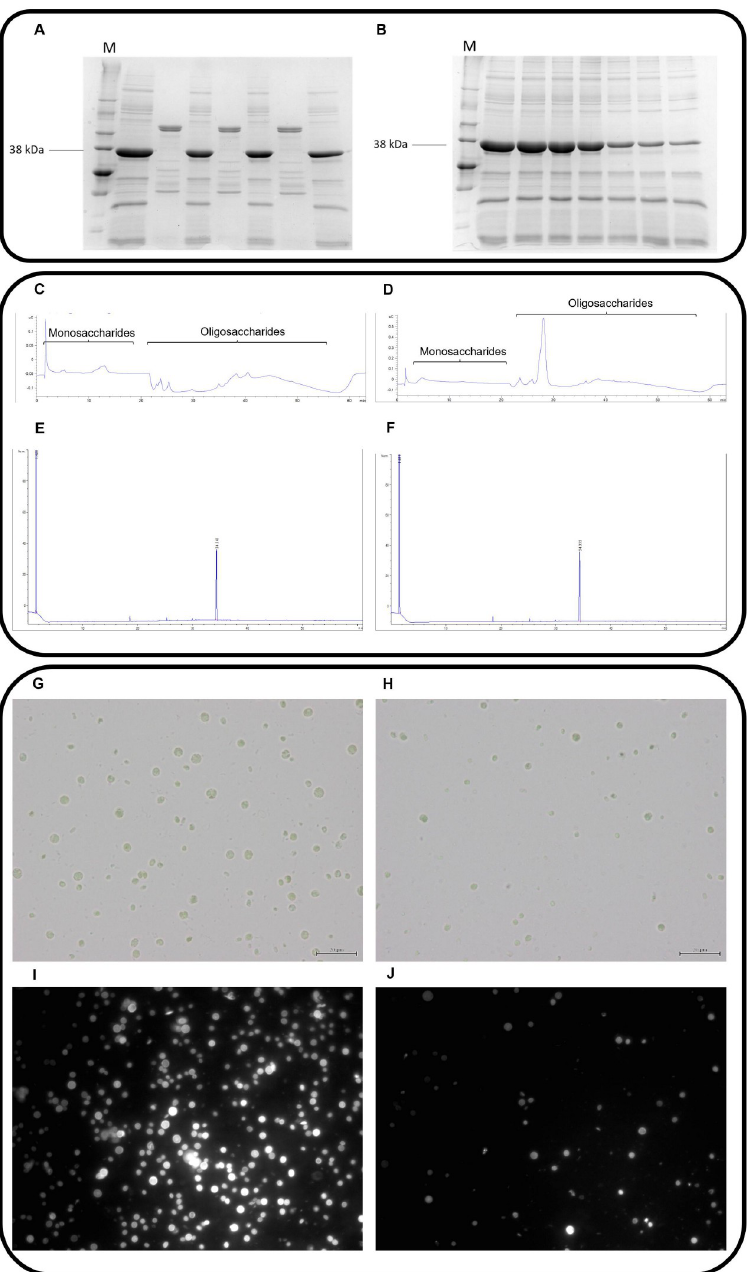
Fig 2. Illustrative images from raw results of each methodology applied across steps 2 and 3 of the laboratory protocol to disrupt Chlorella vulgaris cell wall. A) SDS-PAGE gels visualization to describe proteolysis experiments. M–molecular marker, 38 kilodaltons corresponds to peptidoglycan N-acetylmuramic acid deacetylase enzyme. Wells 1, 3 and 7 correspond to the control. Wells 2, 4 and 6 correspond to the incubation of the enzyme with pancreatin at time intervals of 15 min, 30 min and 1 hour, respectively; B) SDS-PAGE gels visualization to describe thermostability experiments. M–molecular marker, 38 kilodaltons corresponds to peptidoglycan N-acetylmuramic acid deacetylase enzyme. Wells 1–7 correspond to the incubation of the enzyme at 30 ˚C to 55 ˚C; C-D) HPLC chromatogram to exemplify mono- and oligosaccharides quantification in the control and in the mixture treatment, respectively; E-F) GC chromatogram to exemplify fatty acids quantification in the control and in the mixture treatment, respectively;; G-H) bright-field microscope observation for cell counting in the control and in the mixture treatment, respectively ( × 400; scale bar: 20 μ m); I-J) fluorescence intensity for Chlorella vulgaris cell wall disruption in the control and in the mixture treatment, respectively ( × 400).